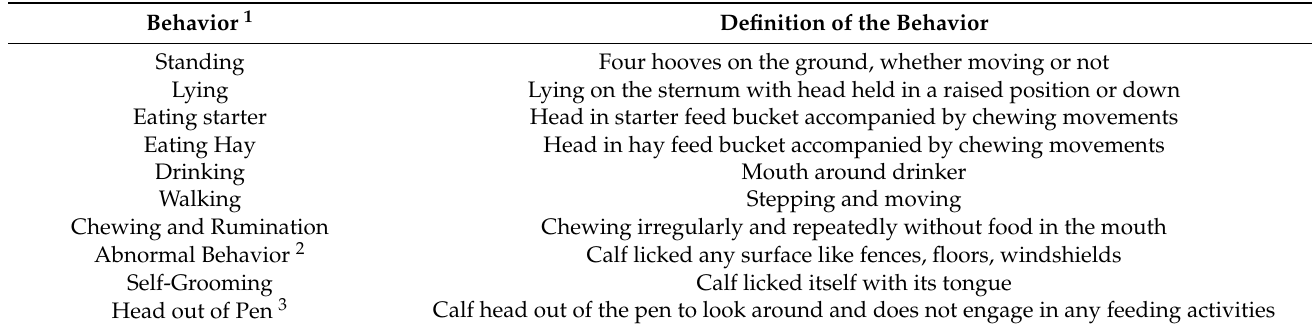
Table 2. Definition of the calf